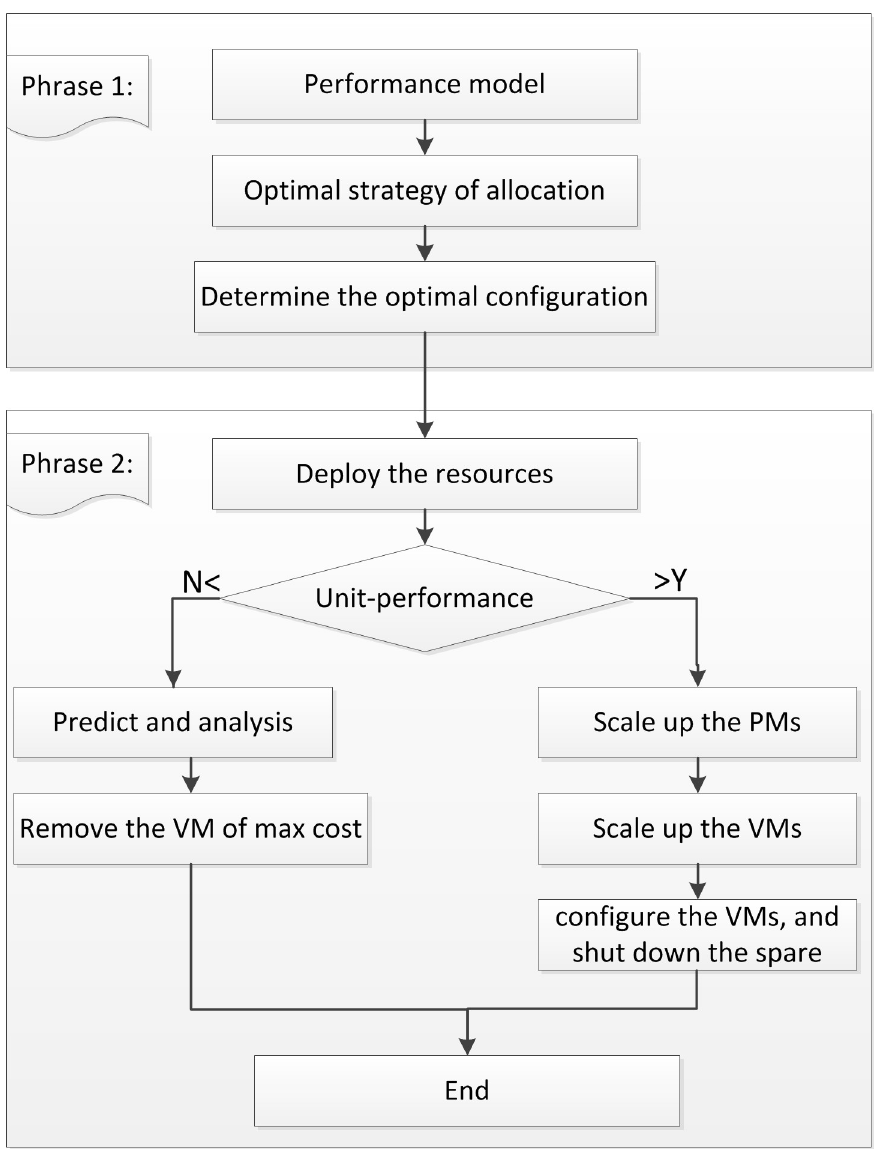
Fig 2. A framework of the entire system